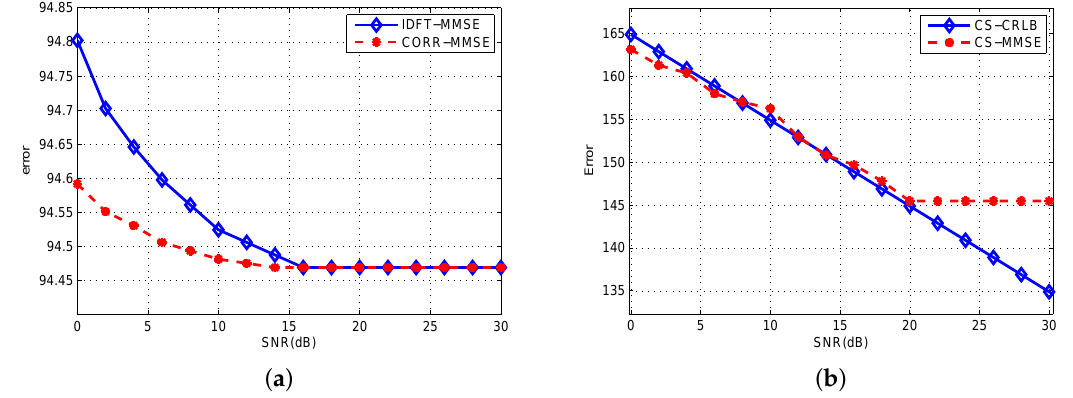
Figure 6. Monte Carlo tests of target estimation. ( a ) MMSE of IDFT and CORR method; ( b ) CRLB and MMSE of CS